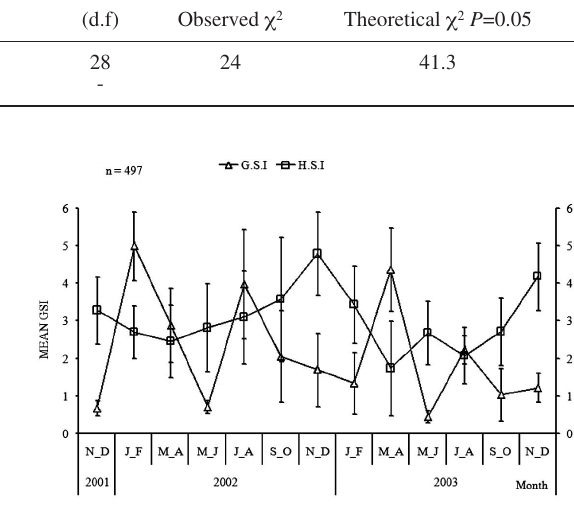
Fig . 4. – The bimonthly evolution of the mean gonadosomatic (GSI) and hepatosomatic (HSI) indexes for M. merluccius females during the sampling